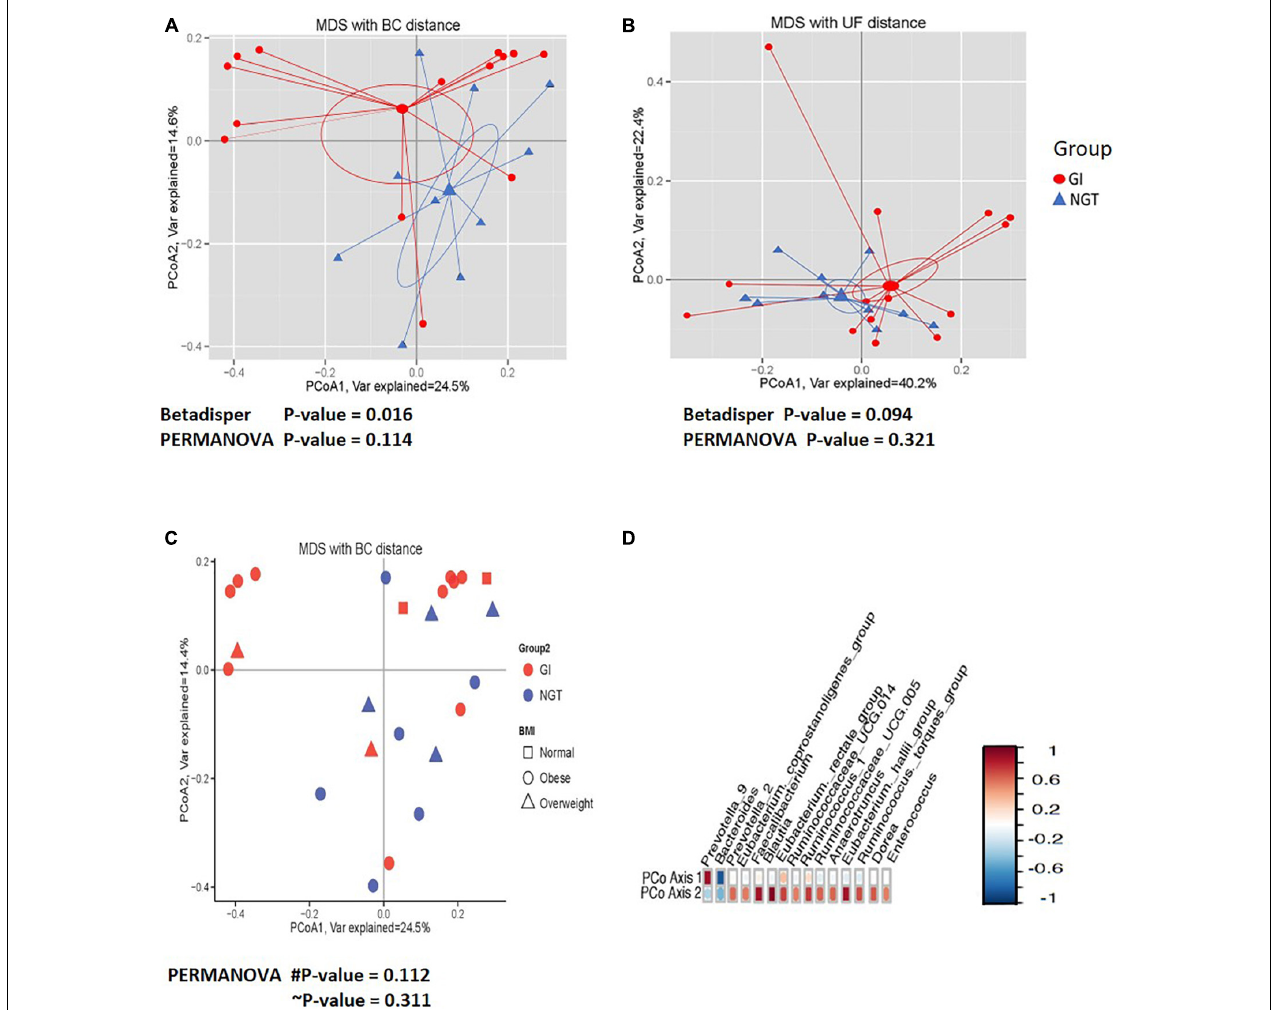
FIGURE 3 | The comparisons of the gut microbiota community ( β diversity) between GI (red circle) and NGT (blue) groups. (A) Principal coordinate analysis (PCoA) plot based on the OTUs relative abundance using the Bray–Curtis (BC) distance. (B) PCoA plot based on the phylogenetic relationship using the UniFrac (UF) distance. The larger shapes are the centroids and linear lines are connected from the samples to the centroid for each group. (C) PCoA plot based on the OTUs relative abundance using the BC distance according to the BMI classification [normal (square), overweight (triangle), and obese (circle)] between GI (red circle) and NGT (blue) groups. PCoA1 and PCoA2 account for the horizontal and the vertical variances, respectively. The symbol # indicates p -value for comparison between GI and NGT groups. The symbol ∼ indicates p -value for comparison between BMI status. p -value < 0.05 was considered as statistically significant. (D) Correlation plot showing the OTUs with the high correlation with first (PCoA1) and second (PCoA2) axes. The red color indicates a positive correlation and the blue color indicates a negative correlation. GI, glucose intolerance; NGT, normal glucose tolerance; MDS, multidimensional scaling; BMI, body mass index; OTU, operational taxonomic